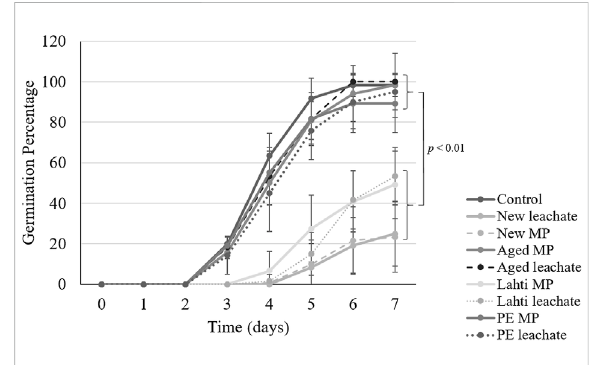
FIGURE 1 Percentage of germinated seeds with time exposed to